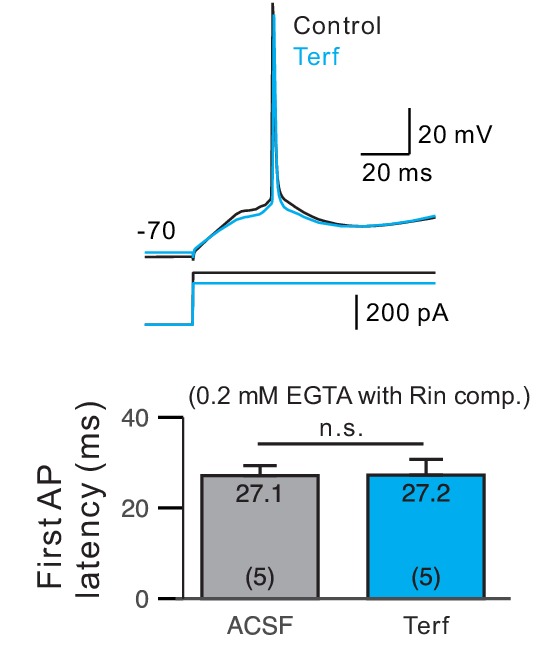
First spike latency was not affected by Terf in experiments with weak Ca2+ buffering.Parallel analysis to results presented in Figure 5E but with 0.2 mM EGTA internal solutions. Rin compensated by decreasing current step amplitude was adjusted to compensate for the effect increased Rin measured in each cell.